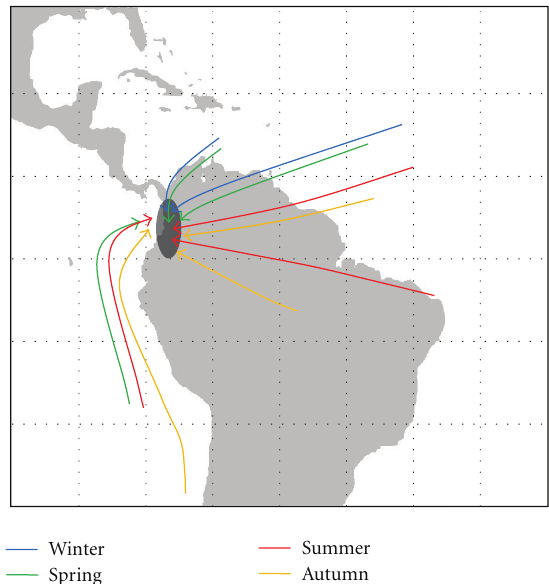
Figure 9: Summary of the seasonal moisture particle trajectories which contribute to continental MCS genesis. Colors represent the trajectories for boreal: winter (blue), spring (green), summer (red) and autumn